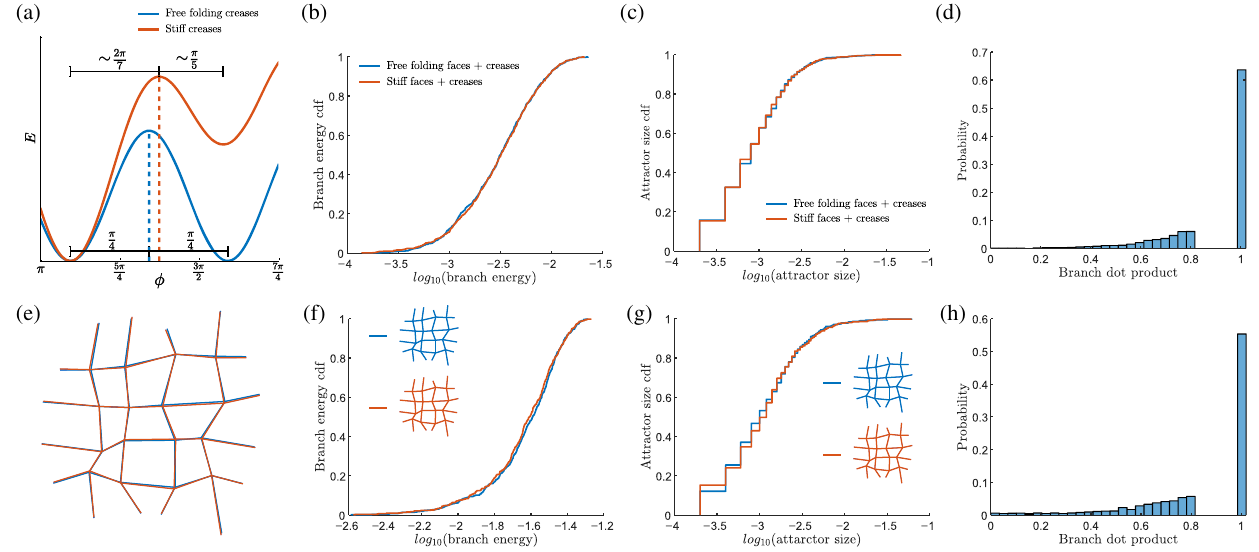
FIG. 10. Varying material models changes landscape details but maintains underlying structure of exponential minima. (a) Simulating a 4-vertex with stiff creases results in the same two modes of an idealized vertex, as long as the creases are not overwhelmingly stiff. The shift in minima position causes a moderate deviation from the mechanical advantage rule for sufficiently stiff creases. (b) and (c) Comparing a pattern with free-folding faces and creases to the same pattern with stiff faces and creases, the number of branches remains similar. Furthermore, the distribution of branch energies and attractor sizes is statistically indistinguishable, implying that the glassy structure retains the same statistics. (d) When branches of the patterns with free-folding and stiff faces or creases are paired up, we find that most random attempts to fold the system enter the same branch for both patterns, showing how corresponding branches remain “ close ” in configuration space. (e) Realistic origami structures are expected to have manufacturing errors in vertex placement. The blue and orange pattern ’ s vertices differ in location by 2% of the mean lattice spacing. (f) – (h) The same metrics as in (b) – (d) show how the landscape of patterns with manufacturing errors retain the same statistics as the